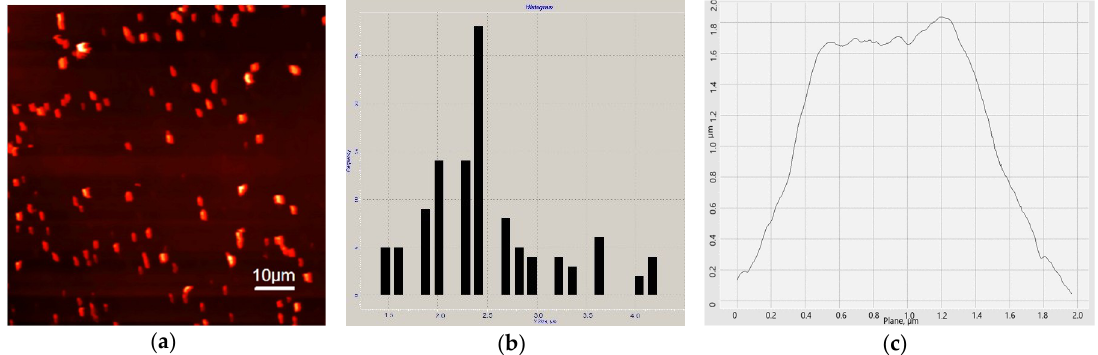
Figure 2. Atomic force microscopy (AFM) images of microcapsules. An AFM micrograph of a layer of aggregated and single polyelectrolyte microcapsules (PMCs) ( a ); a histogram of 100 microcapsules ( b ); and the geometric size of a single microcapsule ( c ). PMC micrographs obtained by phase‐contrast and scanning electron microscopies are shown in 180